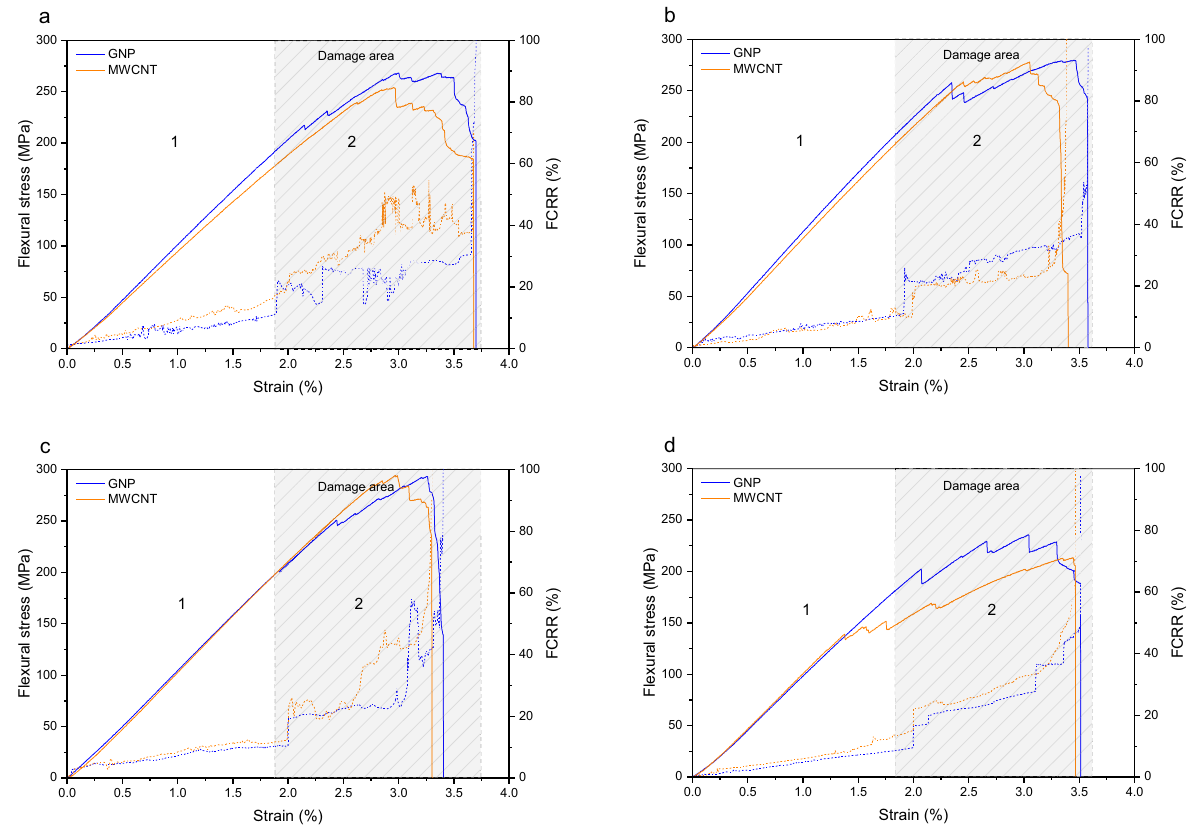
Figure 4: Flexural stress and FCRR as a function of strain in GNP - glass and MWCNT - glass composites: ( a ) 0.5, ( b ) 1.5, ( c ) 3, and ( d ) 5